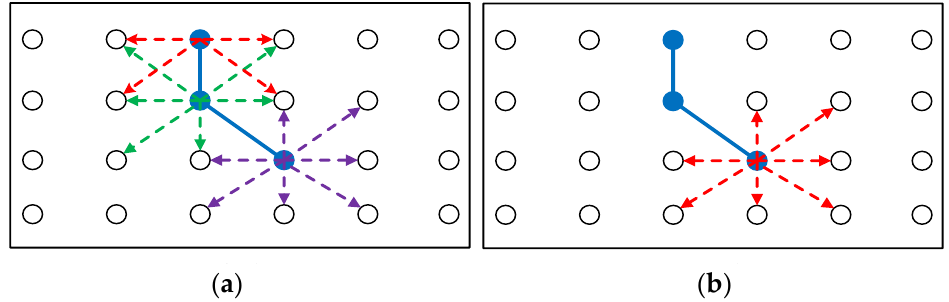
Figure 1. Schematic diagram of the development possibilities (The solid dots are the developed steps, the hollow dots are the undeveloped steps, and the arrows are the possible development paths): ( a ) The negative leader; ( b )The positive leader.